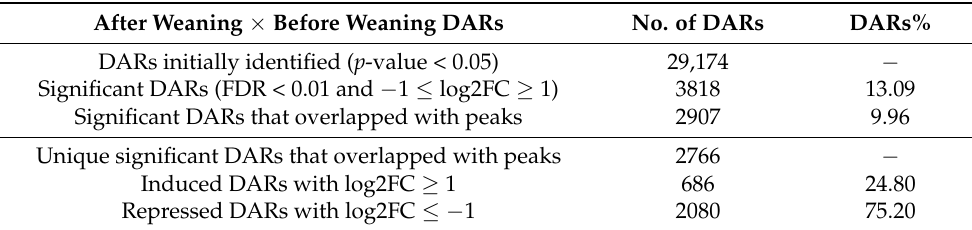
Table 3. Number of differentially accessible regions (DARs) for after weaning vs. before weaning comparison, significant DARs (FDR < 0.01 and − 1 ≤ log2FC ≥ 1), significant DARs that over- lapped with peaks, and unique significant DARs that coincided with peaks, including induced and repressed DARs.